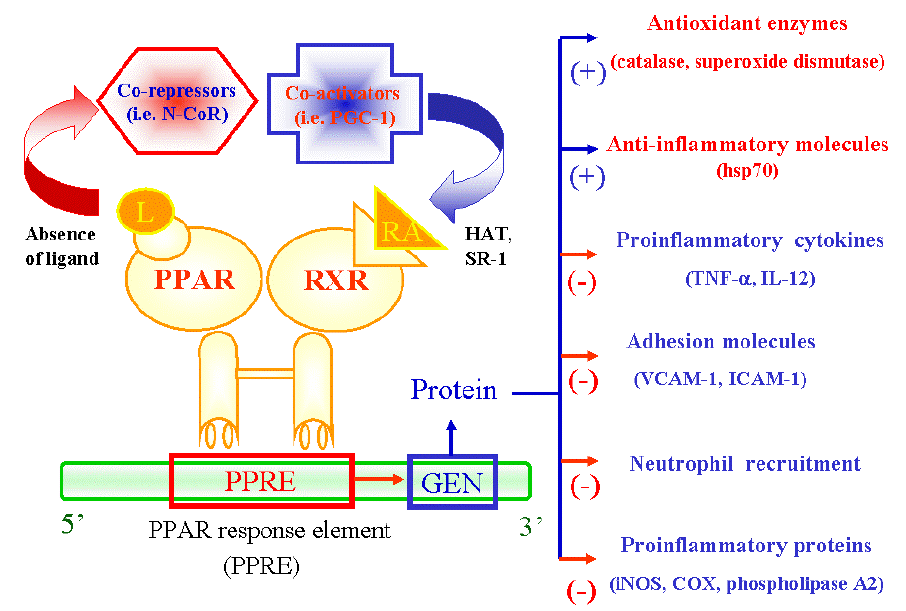
FIGURE 1. Similar to other nuclear hormone receptors, PPAR acts as a ligand-activated transcription factor. PPAR- α , when activated after binding with specific ligand, interacts with RXR and regulates the expression of target genes. These genes are also involved in the catabolism of fatty acids. Conversely, PPARs are activated by different ligands and affect the expression of genes involved in the storage of fatty acids. PPAR- β is only weakly activated by fatty acids, prostaglandins, and leukotrienes, and has no known physiologically relevant